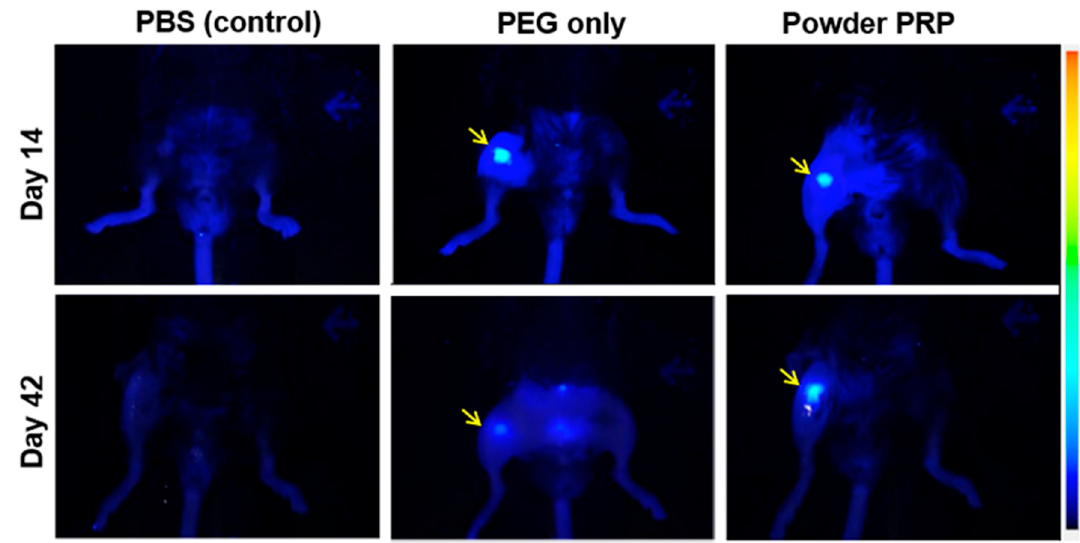
Figure 7. Degradation of PEG microspheres as a function of PRP loading in mouse knee. Microspheres were prepared with 4-arm PEG–Ac and PEG–diSH as a crosslinker at 10% w / v in PEG. Powder PRP was loaded at 10% w / v . Infrared FluoroSphere-loaded PEG hydrogel microspheres with or without PRP were injected into the mouse knee by intra-articular injection. The fluorescent signal was followed up to 42 days after injection by an In Vivo Imaging System. PBS injection served as a control. Results showed that both PEG-only and PRP-loaded microspheres were present in the joint space (indicated by yellow arrow) 14 days after injection but only PRP-loaded microspheres remained there until 42 days after